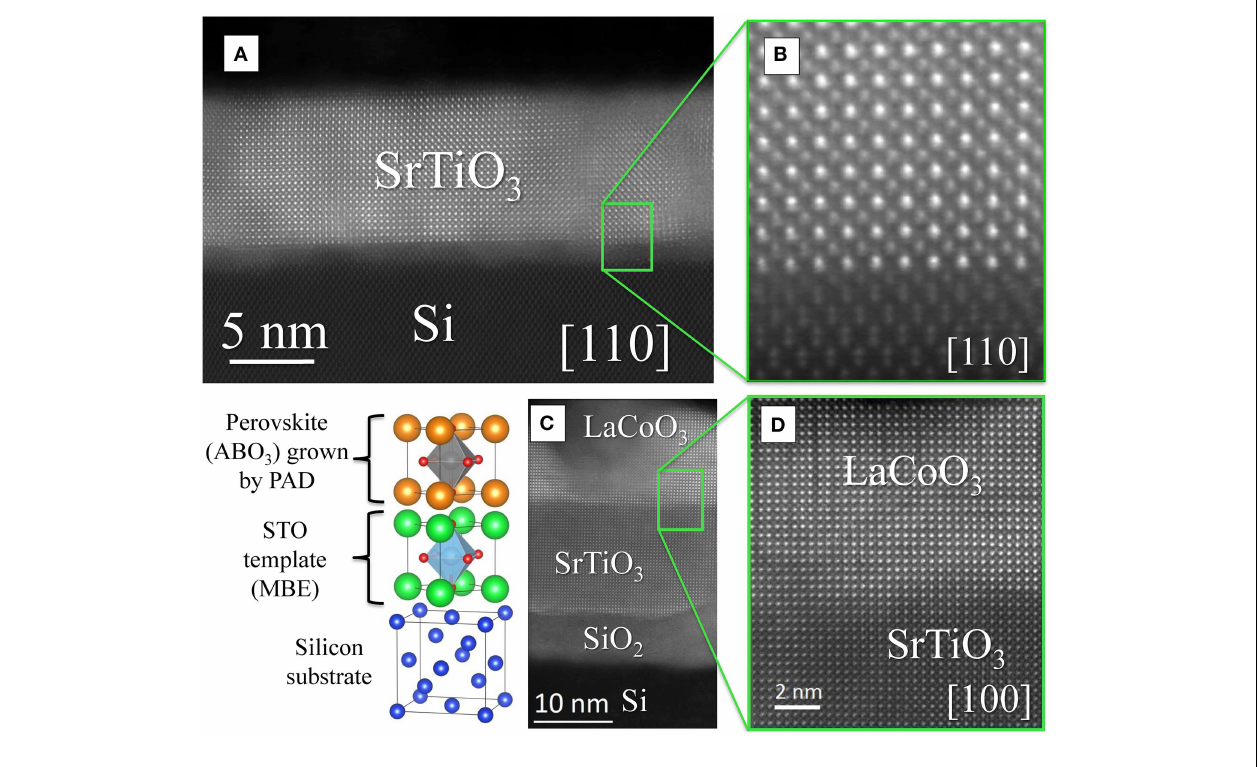
top of a STO buffer layer grown by MBE on a (001)-Si substrate. (D) Magnified view of the interface exhibiting the epitaxial similarity between STO buffer layer and LCO film. All images were acquired with a Nion UltraSTEM 100 dedicated aberration-corrected STEM, operated at 100 kV, which features an atomic-size probe ∼ 1.0Å HAADF-STEM imaging resolution.